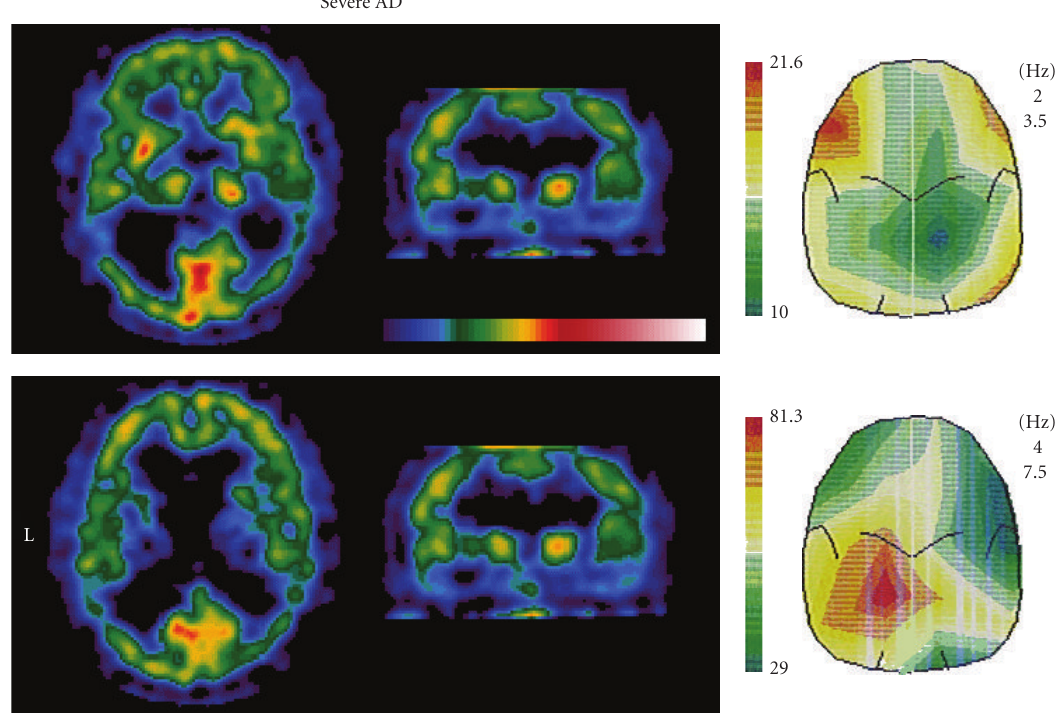
Figure 5: Sample of SPECT neuroimaging (Tc-99 HMPAO) and EEG brain mapping in a severe AD patient. Topographic scalp distribution of the EEG power on the 2.0 to 3.5Hz frequency band (top right) and 4.0 to 7.5 Hz frequency band (bottom right) is shown. For more details, see